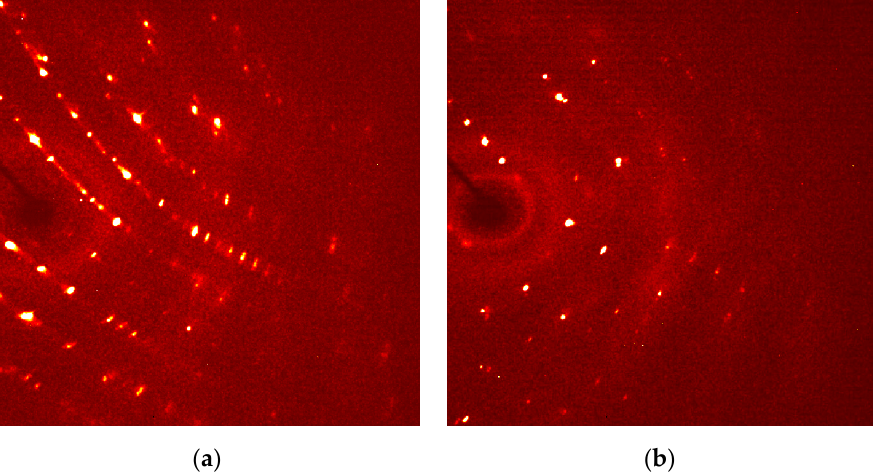
Figure 3. Diffraction patterns for low-temperature ( a ) and high-temperature ( b ) phases. Reflections corresponding to I-centering are absent in the high-temperature phase. Upon transition to the low-temperature phase, the reflections